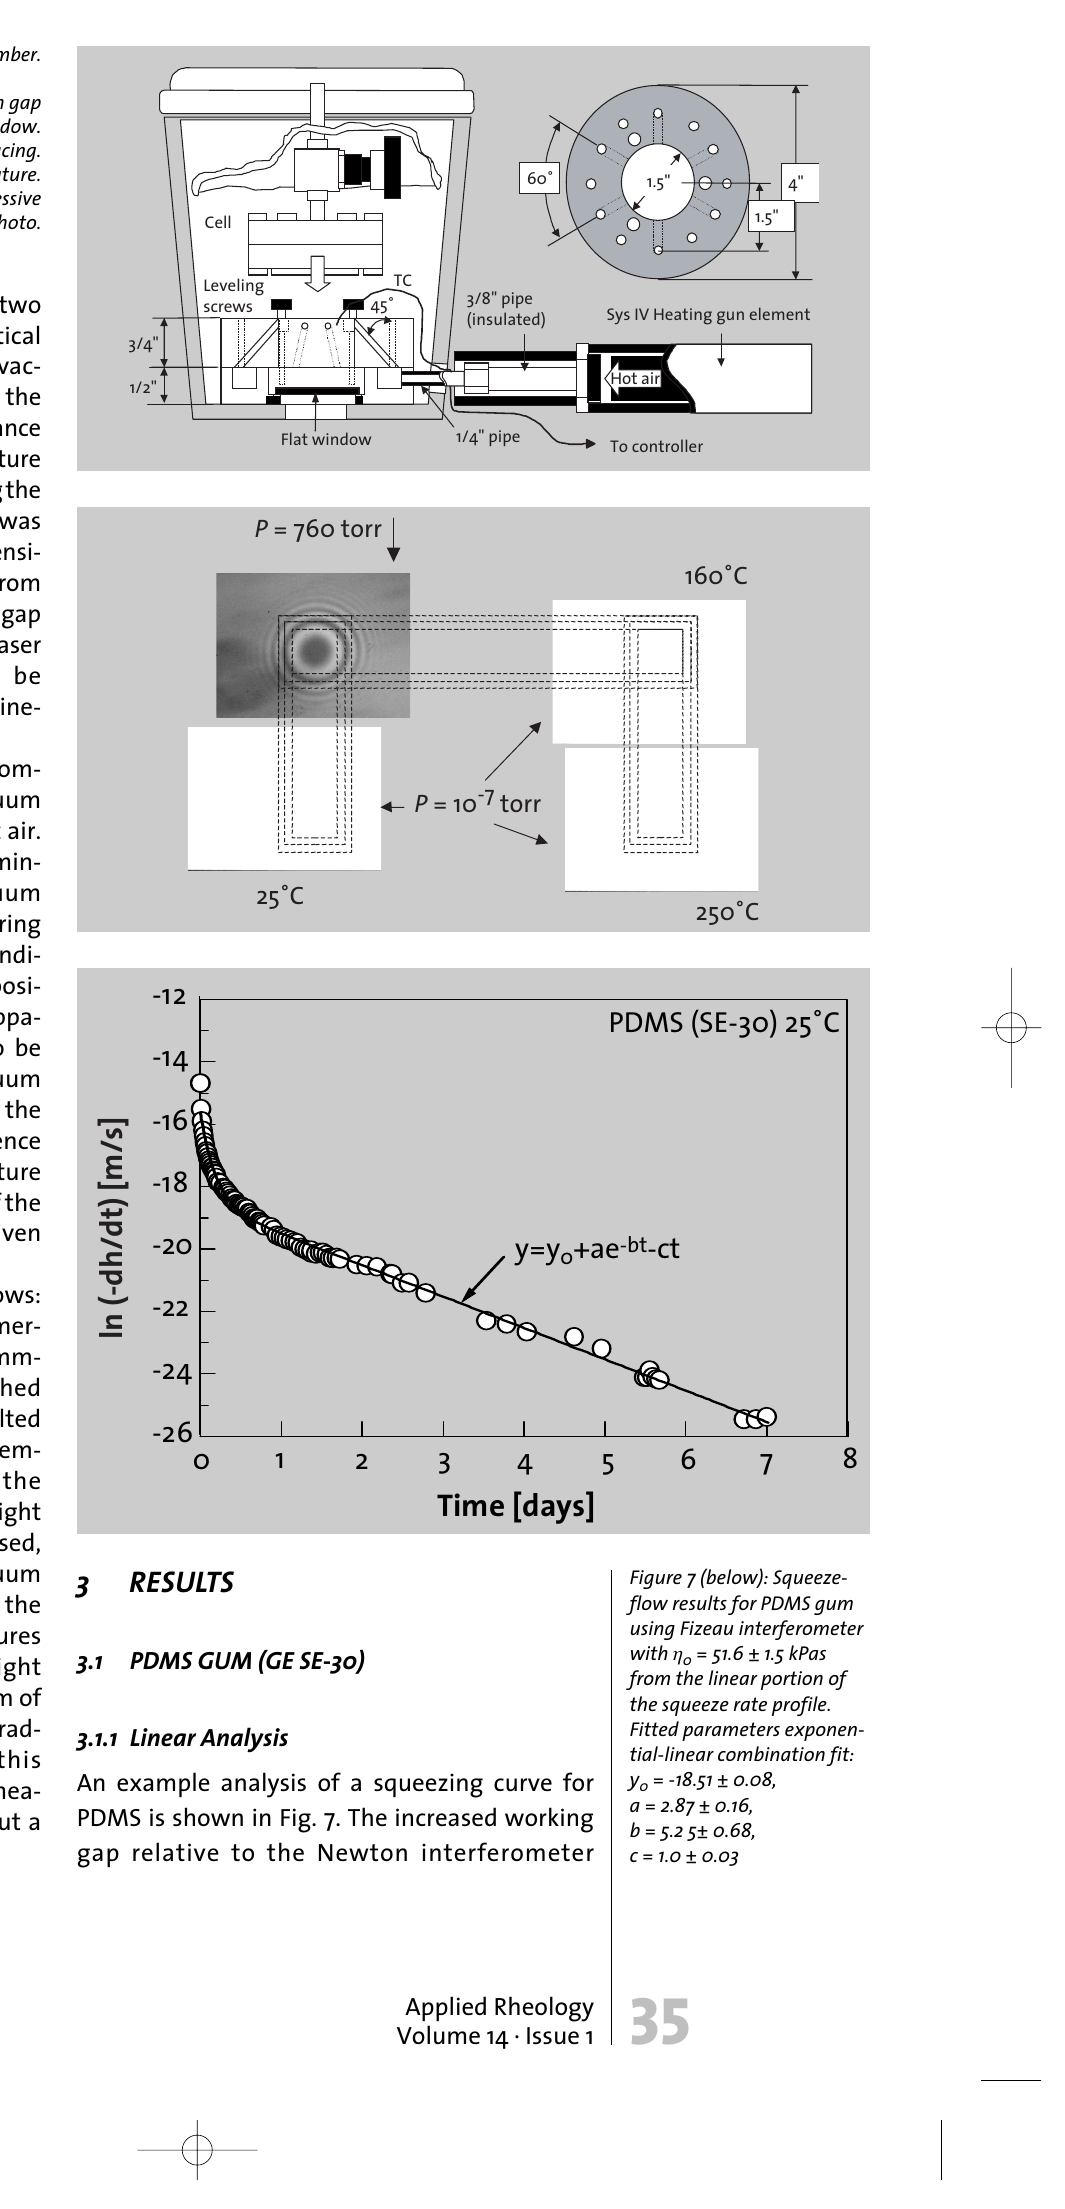
Figure 6 (middle): Interference patterns for a vacuum gap with PCX lens in contact with the vacuum window. Dashed line show constant ring locations and spacing. Photographs at left column taken at room temperature. Uncontrollable environmental vibrations caused excessive oscillation of fringes at lower left